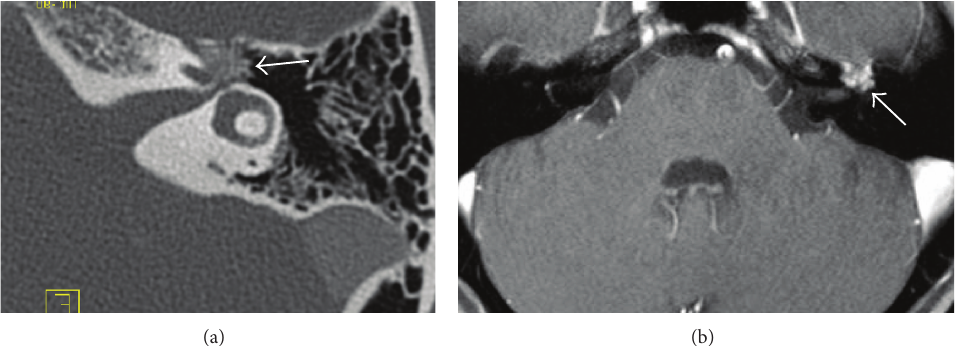
Figure 8: Facial nerve hemangioma. Axial CT (a) demonstrates a mass with trabecular bony matrix centered in the first genu of the facial nerve (arrow). Axial T1 postcontrast fat-saturated MRI (b) demonstrates the enhancing hemangioma (arrow).